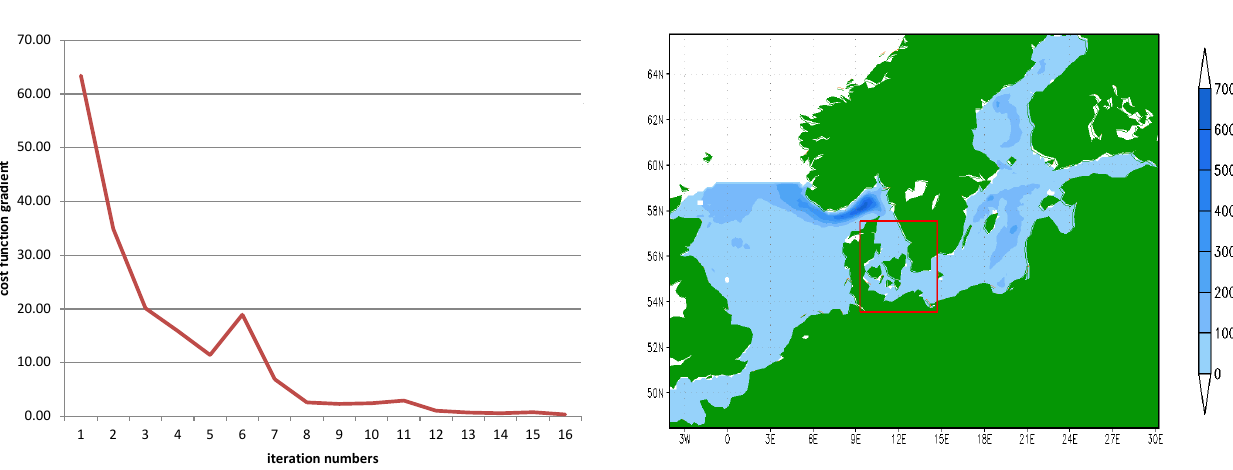
Fig. 5. A case of minimization iteration. The gradient of cost func- tion has descended to be around zero.